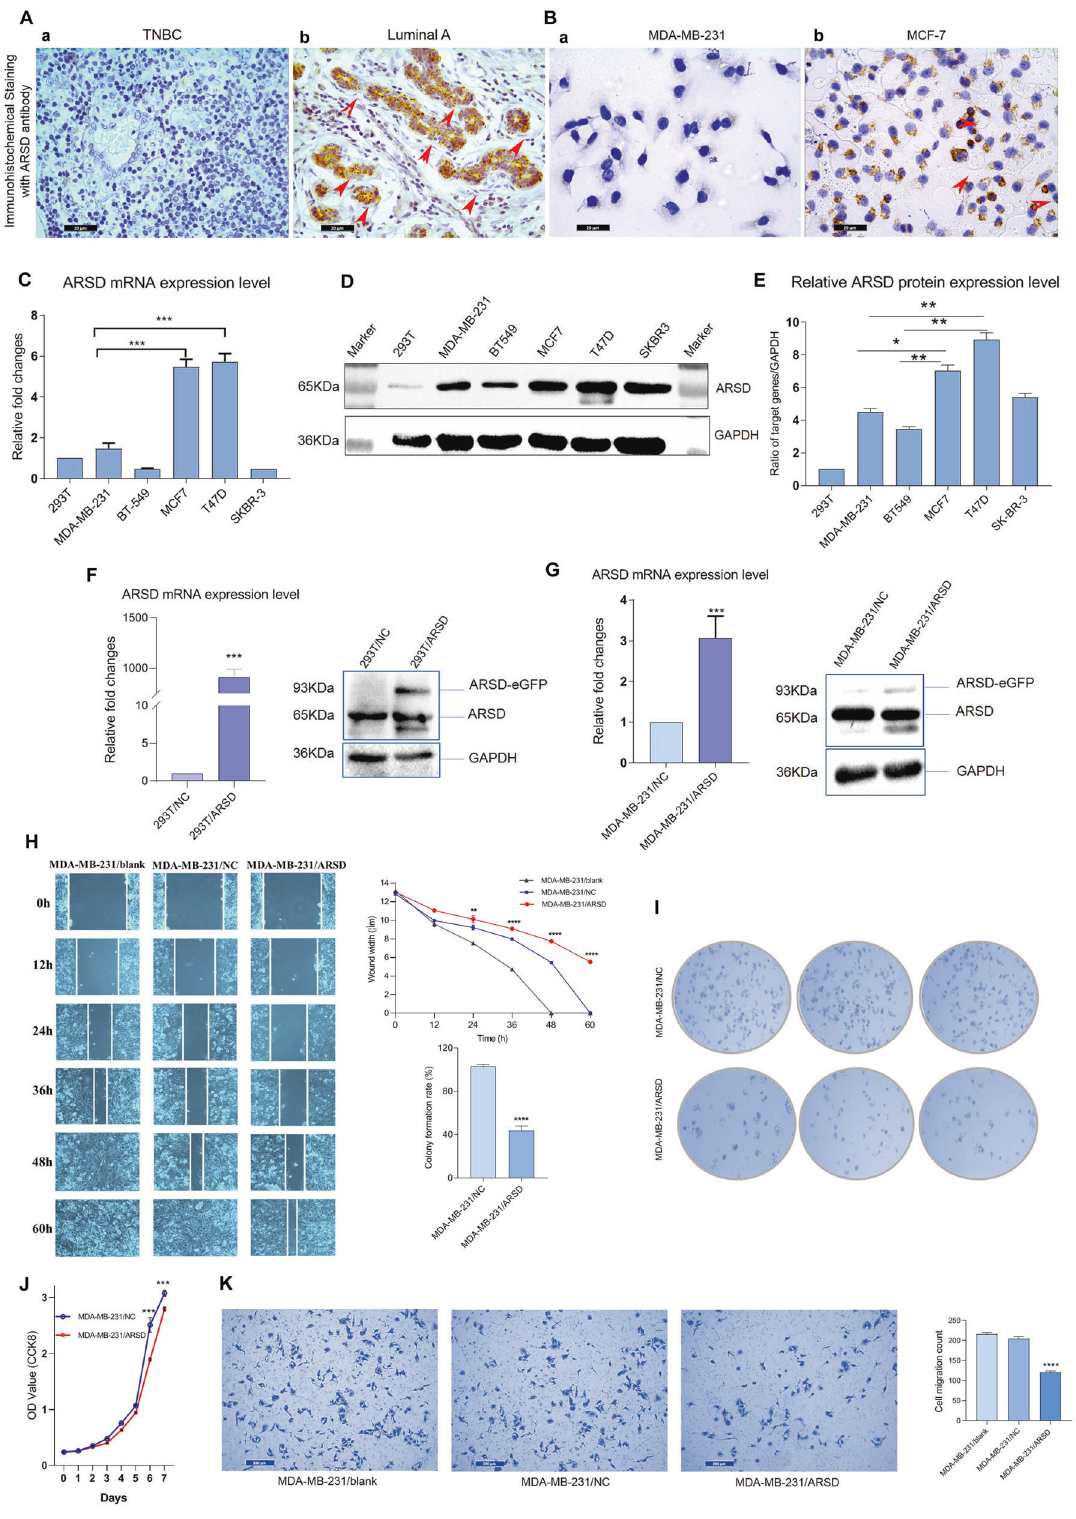
were around two canonical ER α binding sites Fig. 5A, B. The dual luciferase reporter assay showed that ARSD promoter activity was signi fi cantly increased, once ER α , FOXA1, and GATA3 were overexpressed, respectively, suggesting that ER α , FOXA1, and GATA3 could effectively elicit ARSD expression (Fig. 5C; p <